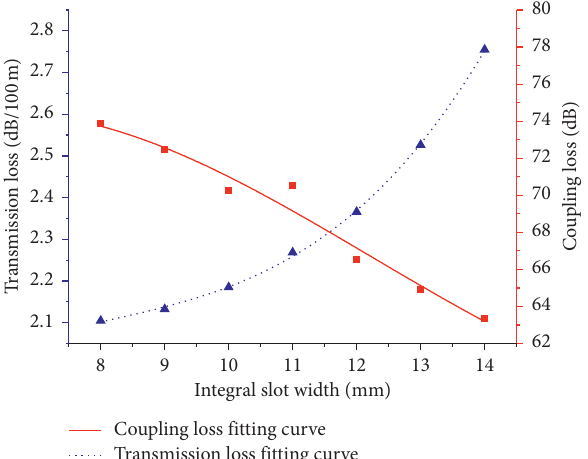
Figure 8: The relationship between the overall groove length of U- groove and cable leakage